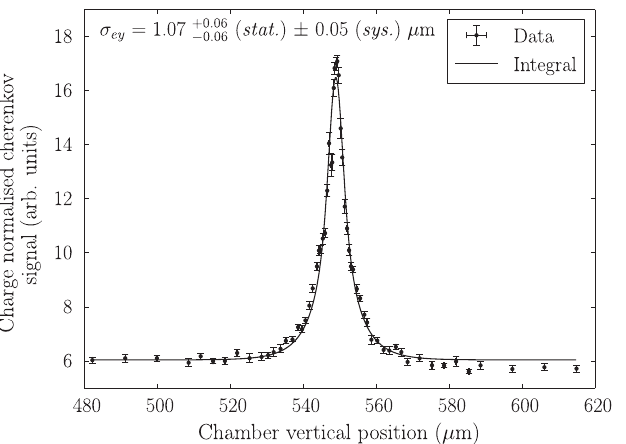
FIG. 20. The corresponding horizontal laserwire scan for the smallest vertical scan, which was required for the combined